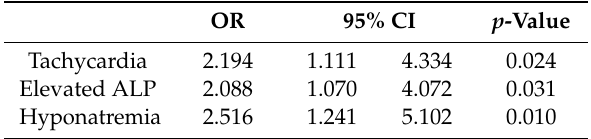
Table 2. Multivariate analysis of parameters associated with re-visiting the ED in 7 days.